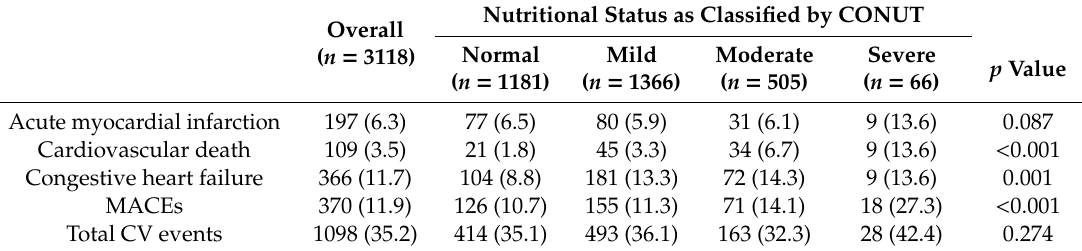
Table 2. Clinical outcomes of patients with di ff erent nutritional status after percutaneous coronary